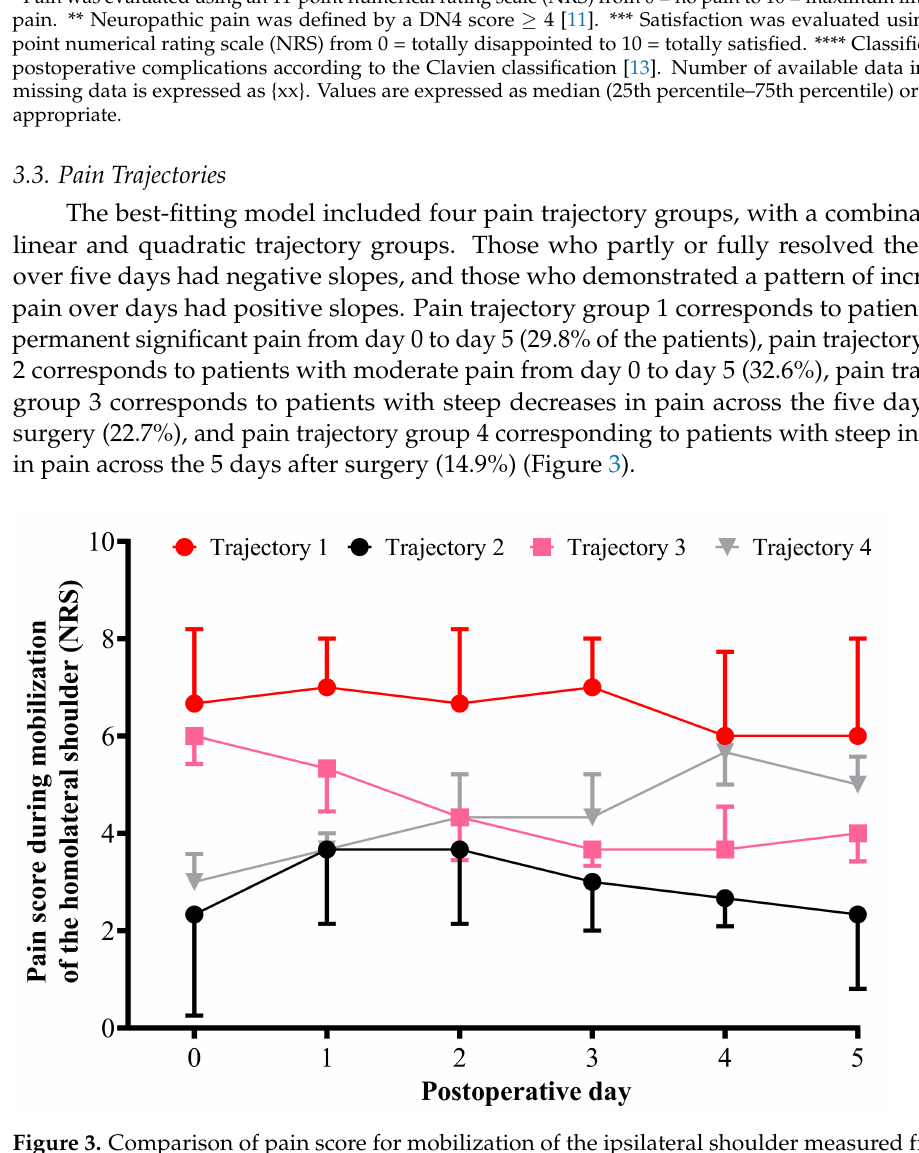
Figure 3. Comparison of pain score for mobilization of the ipsilateral shoulder measured from the day of surgery to postoperative day 5 for each trajectory. For each trajectory the median pain score is represented (numeric rating scale: 11-point scale for patient self-reporting of pain from 0 = no pain to 10 = maximal imaginable pain). The black line represents median pain scores in cluster 1 (permanent significant pain group). The red line represents median pain scores in cluster 2 (permanent moderate pain group). The pink line represents median pain scores in cluster 3 (decreasing pain group). The gray line represents median pain scores in cluster 4 (increasing pain